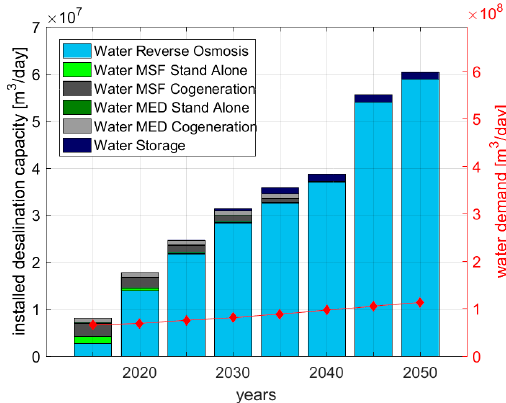
Figure 13. Water desalination capacities required to meet KSA’s total water demand from 2015 to 2050.